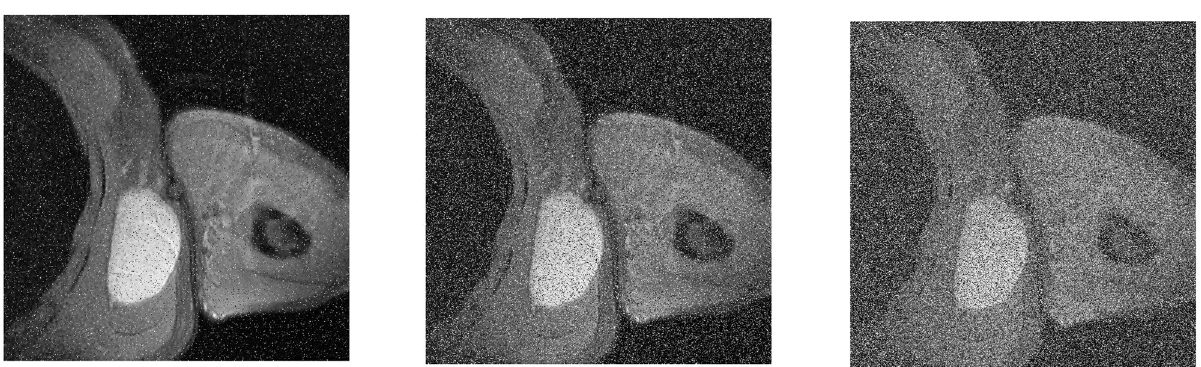
Fig 15. Decrypted image after cropping attack. (a) 1/16 decrypted image, (b) 1/4 decrypted image, (c) 1/2 decrypted image.